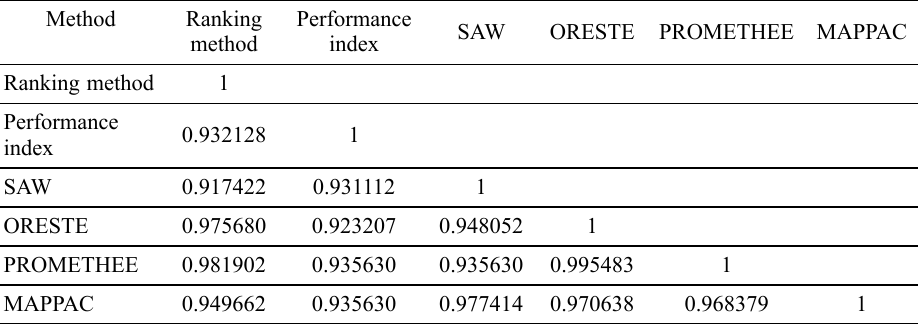
Table 6. Correlation matrix of the results of the investigated